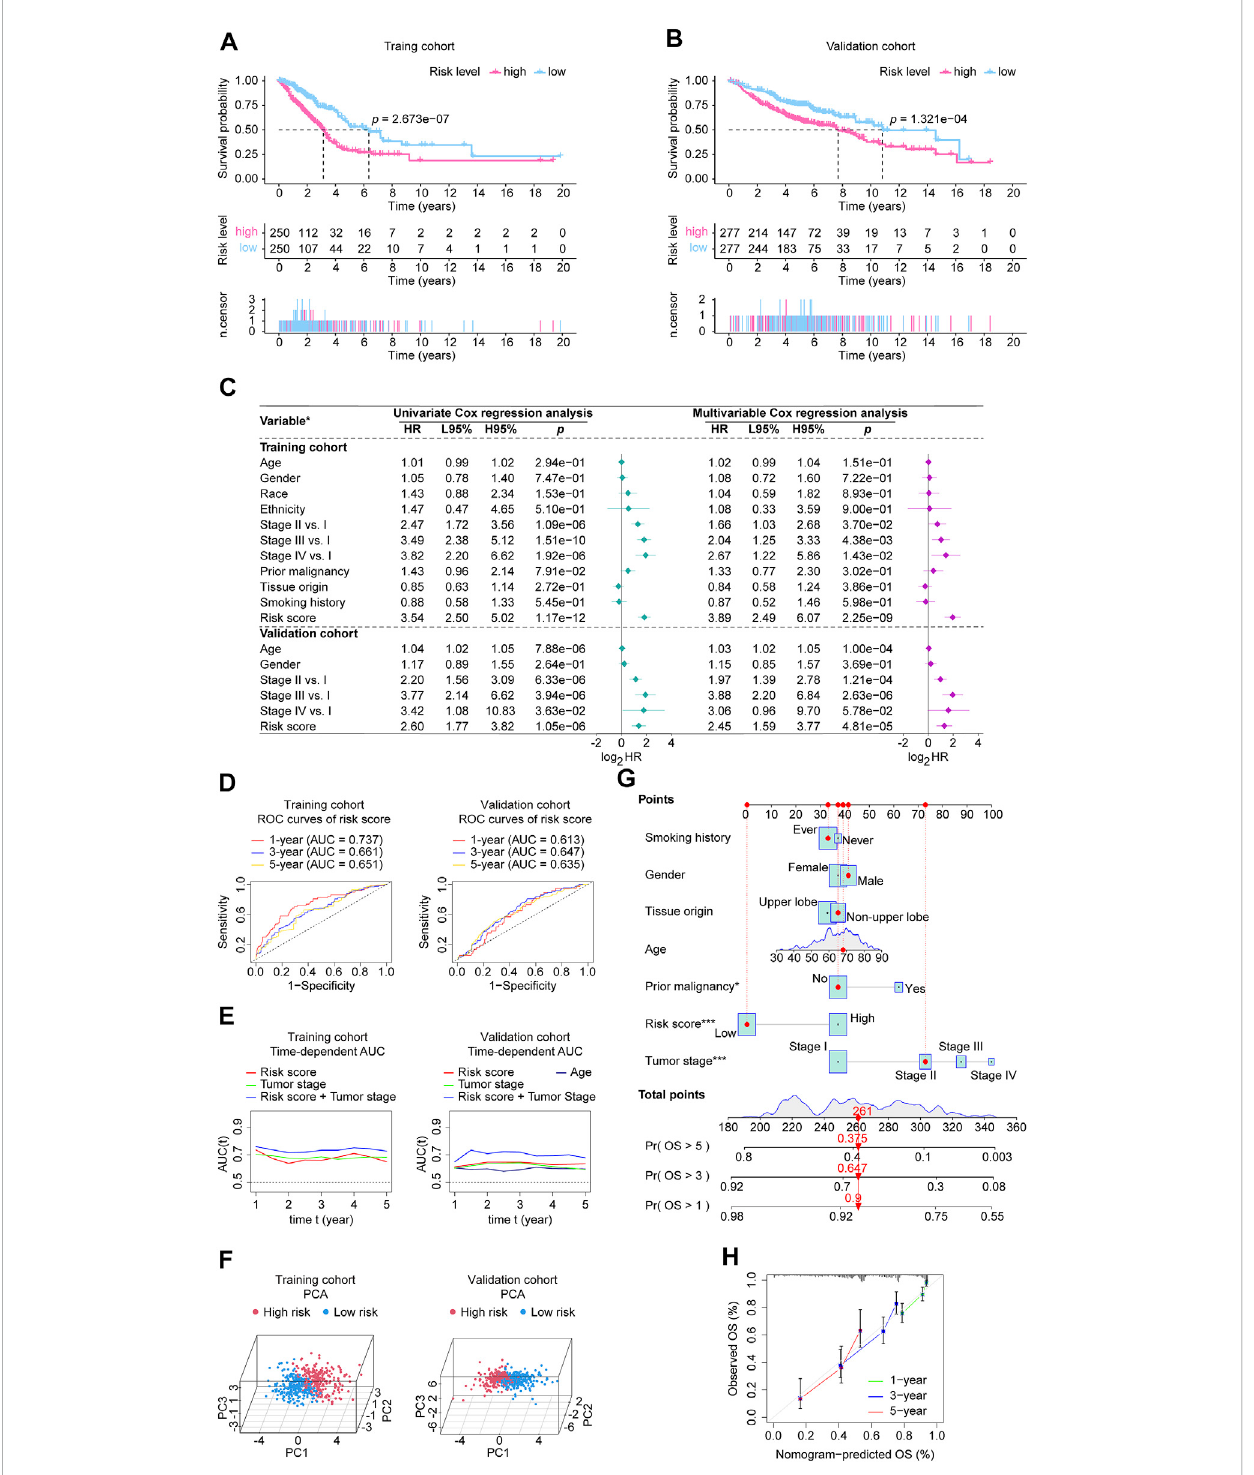
FIGURE 5 ValidationoftheCRLncSigintheinvolvedstudiedcohorts. (A,B) Kaplan-Meieranalysiswasperformedinthetrainingandvalidationcohorts.Patients in each cohort and subtypes were divided into low-risk groups and high-risk groups based on their median risk score. The log-rank test with a p-value < 0.05 suggests the survival difference is signi fi cant. (C) Univariate and multivariable Cox proportional hazards models. *: the variables involved in the studied cohorts, explains as follows: Gender: male vs. female; Race: white vs. non-white; Ethnicity: Hispanic or Latino vs. non-Hispanic or Latino; Prior malignancy: yes vs. no; Tumor origin: upper lobe lung vs. non-upper lobe lung; Smoking history: ever vs. never. (D) ROC curves. The ROC curves value the accuracy for LUAD outcome prediction of our signature at 1-, 3-, and 5-year, respectively. (E) The tAUC analyses compare our signature ’ s prognostic ability with other available clinical characteristics. The larger the AUC, the stronger the model ’ s predictive ability. (F) Principal component analysis scatter plot. (G) The nomogram, a quantitative model for predicting clinical prognosis, to predict 1-year, 3-year, and 5-year OS in the LUAD